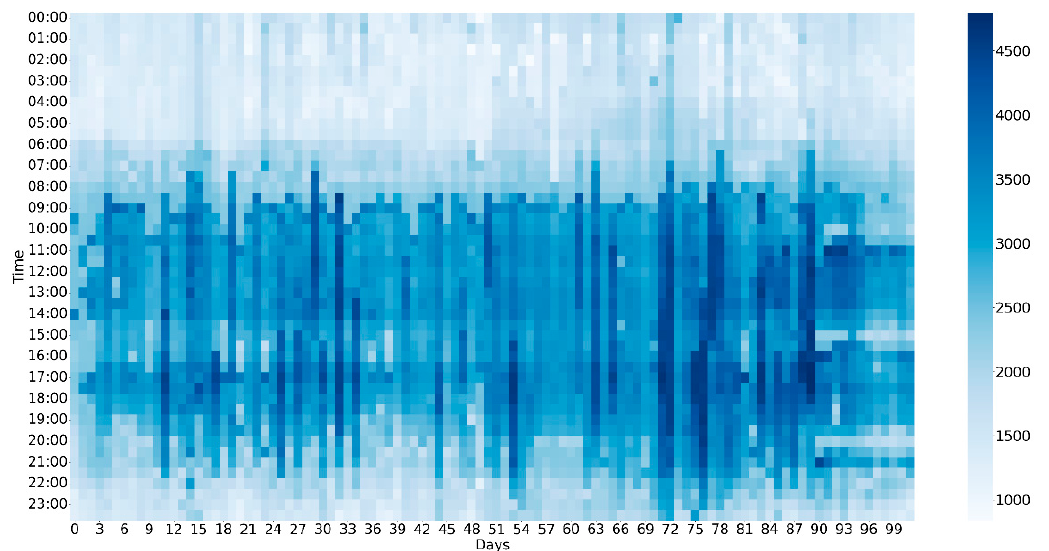
Figure 4. Simulation process.